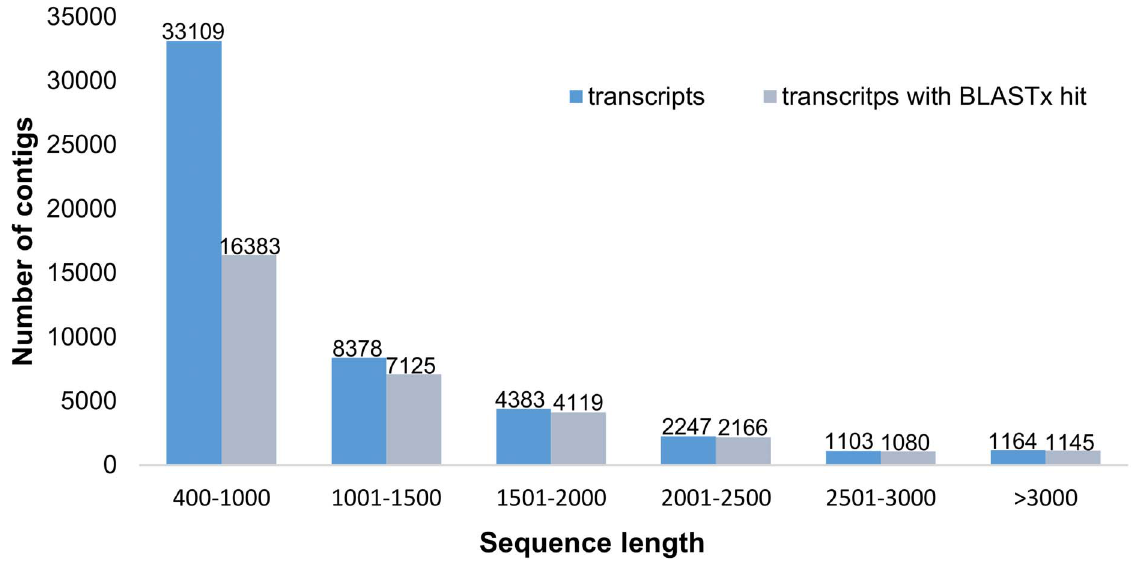
Figure 1. Length distribution of the 50,384 contigs. Histogram of the sequence-length distribution of these transcripts and the transcripts showing BLASTx hits in the nr database with a cut-off e - value of 1e 2 10.